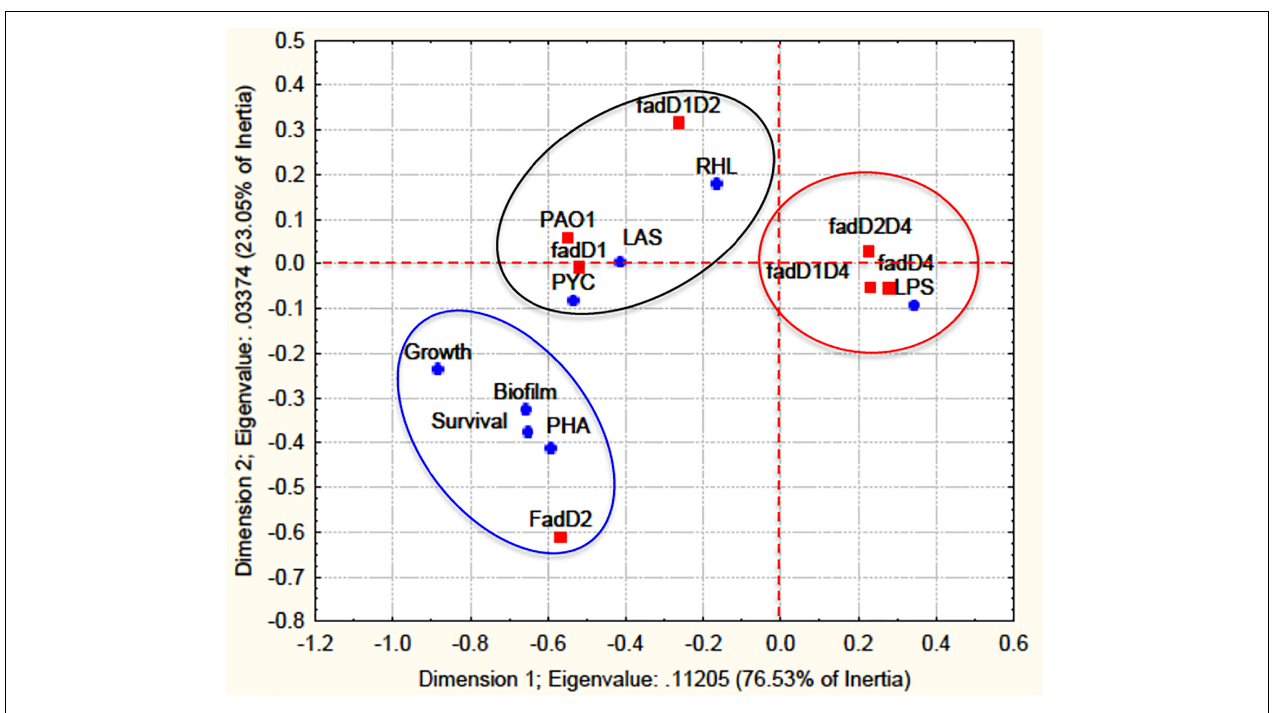
FIGURE 7 | A statistical correlation analysis of virulence factors with fadD mutants. A correlation analysis of virulence factor data from the mutagenesis approach was performed by multivariate exploratory techniques, with 2-D PCA correspondence analysis of frequencies with/without grouping variables using the STATISTICA Software System 8.0, Stat Soft. Inc. The fadD mutants are designated response variables (independent) and virulence factors as dependent variables. Survival, worm survival; Growth, growth in AT and FA; LAS, QS- las/rhl induction; PYC, pyocyanin; RHL, rhamnolipids; PHA, polyhydroxyalkanoates; LPS, lipopolysaccharides; Biofilm, biofilm